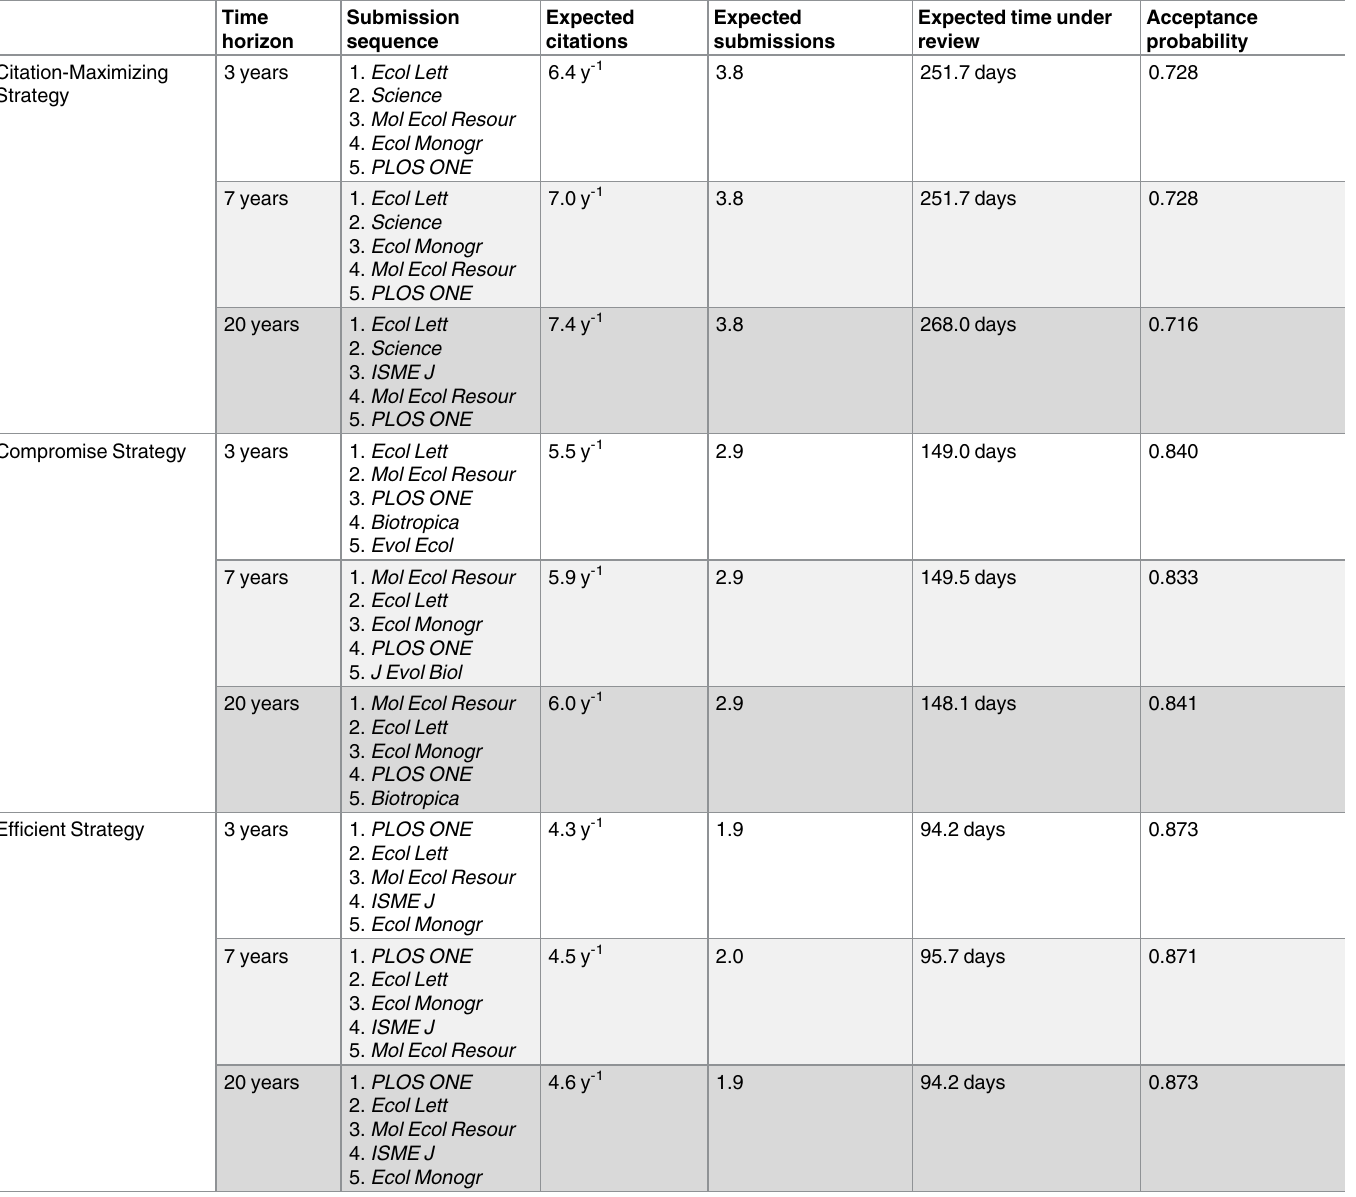
Table 1. Submission sequences to maximize citations under each